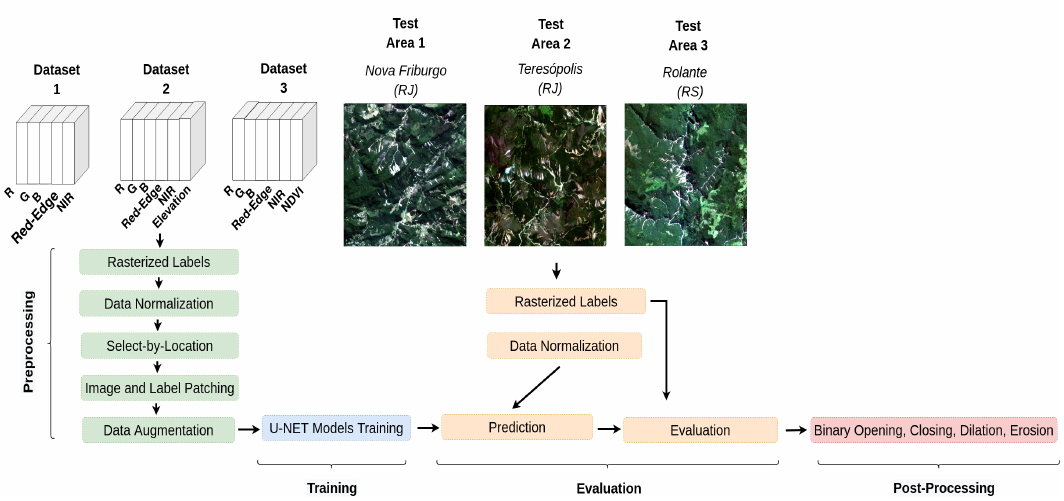
Figure 3. Workflow used to prepare the dataset and train, evaluate, and post-process the deep learning models and the results. “R”, “G”, “B”, “Red-Edge”, and “NDVI” represent the bands red, green, blue, red-edge, and the normalized vegetation index,